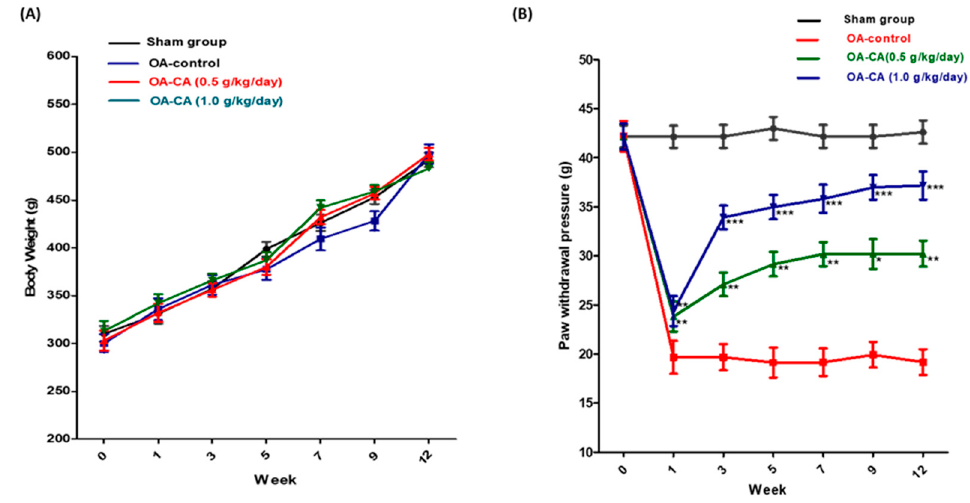
Figure 4. The effect of CA on ( A ) body weight changes, and ( B ) paw-withdrawal pressure in the sham group, OA-control group, and CA (1.0 and 0.5 g/kg/day) treatment groups. Data expressed as mean ± S.D. * p < 0.05, ** p < 0.01, and *** p < 0.001.